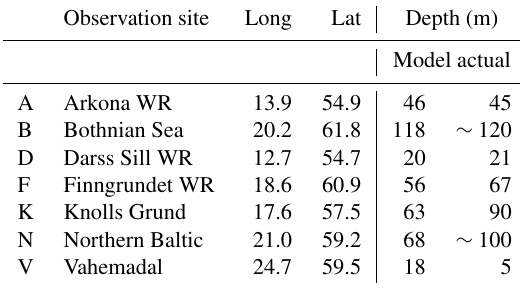
Table 3. Details of wave measurement